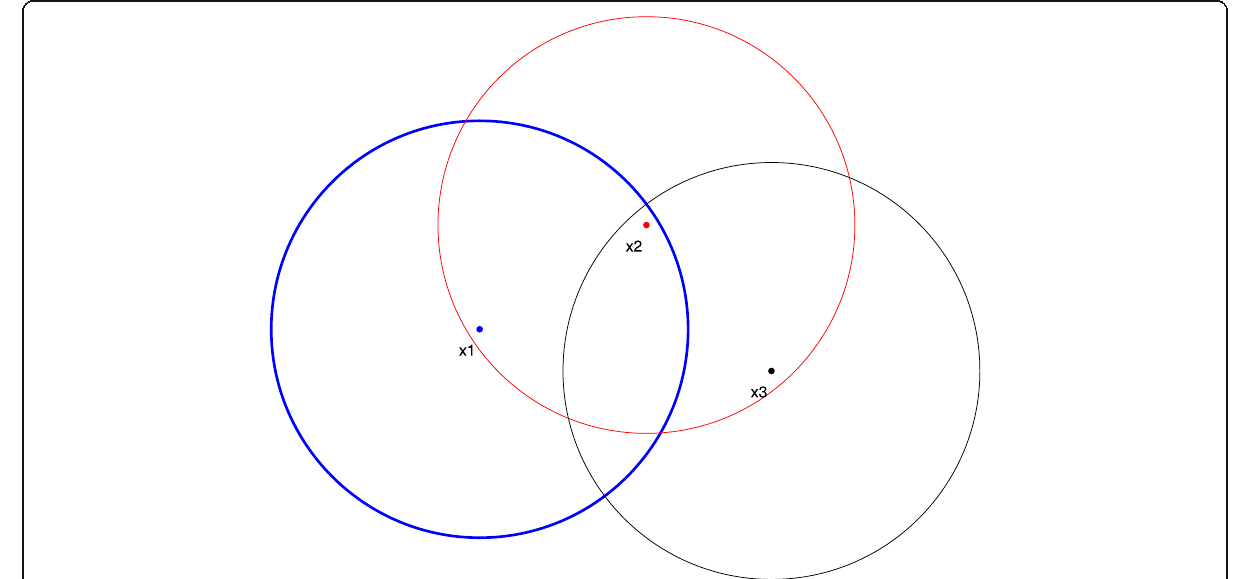
Fig. 1 Density underestimation in Matérn type II